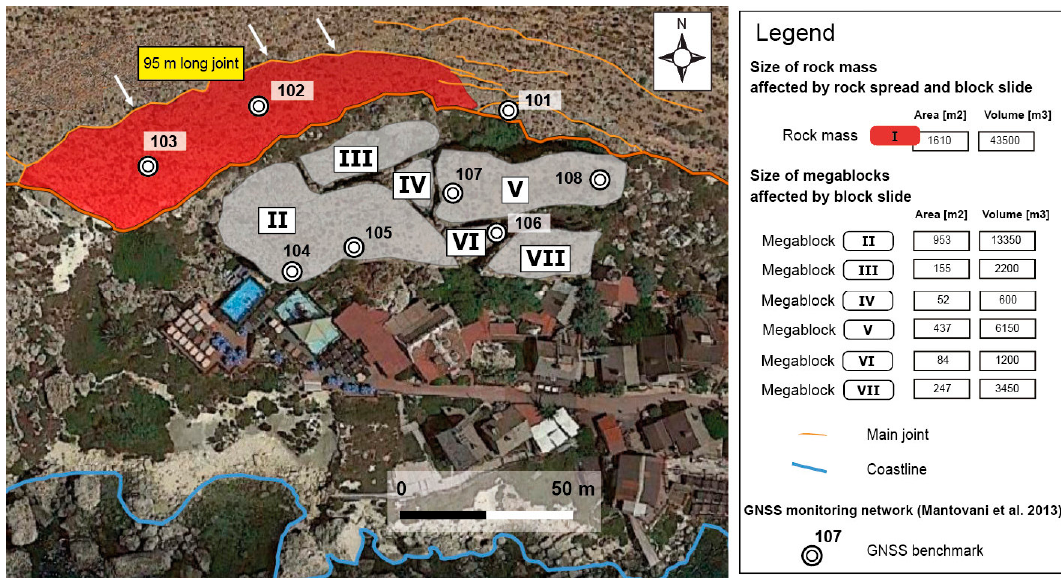
Figure 5. Map showing the main landforms of Il-Prajjet (background GE image). White arrows point to the open joint, which partially isolates and displaces a 43,500 m 3 rock slice. The light grey areas highlight downslope megablocks.